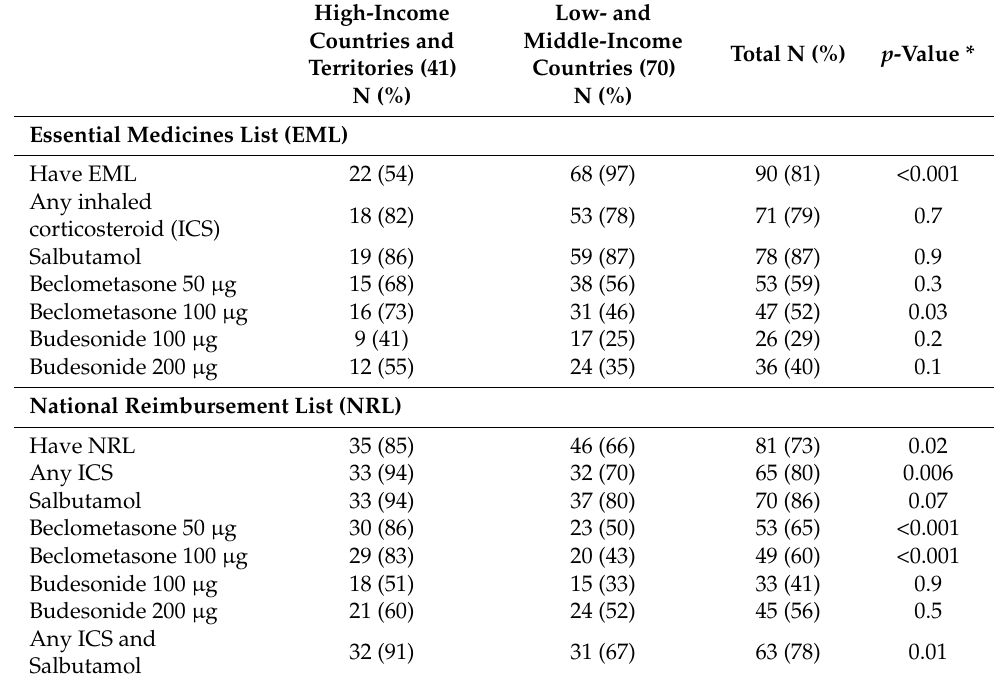
Table 5. Existence of an Essential Medicine List and National Reimbursement List, and